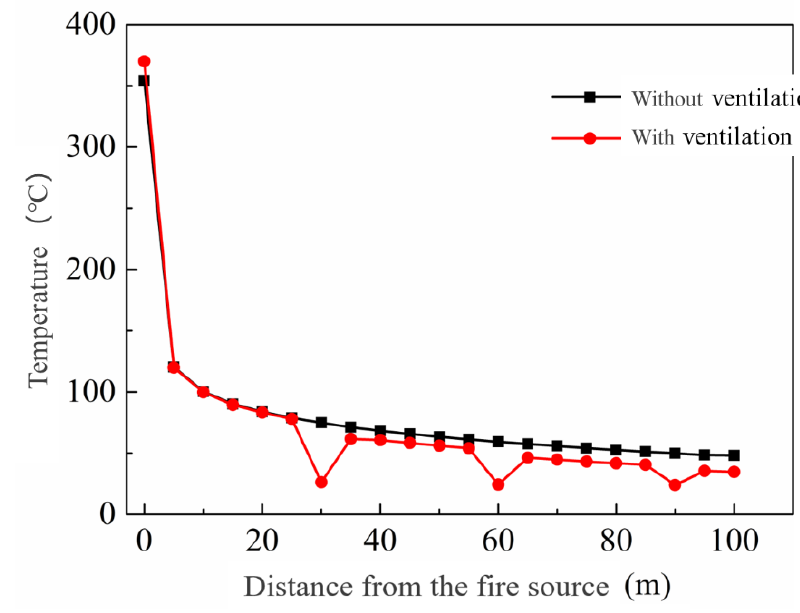
Figure 19. Temperature distribution at 1.8 m height (semitransverse ventilation).